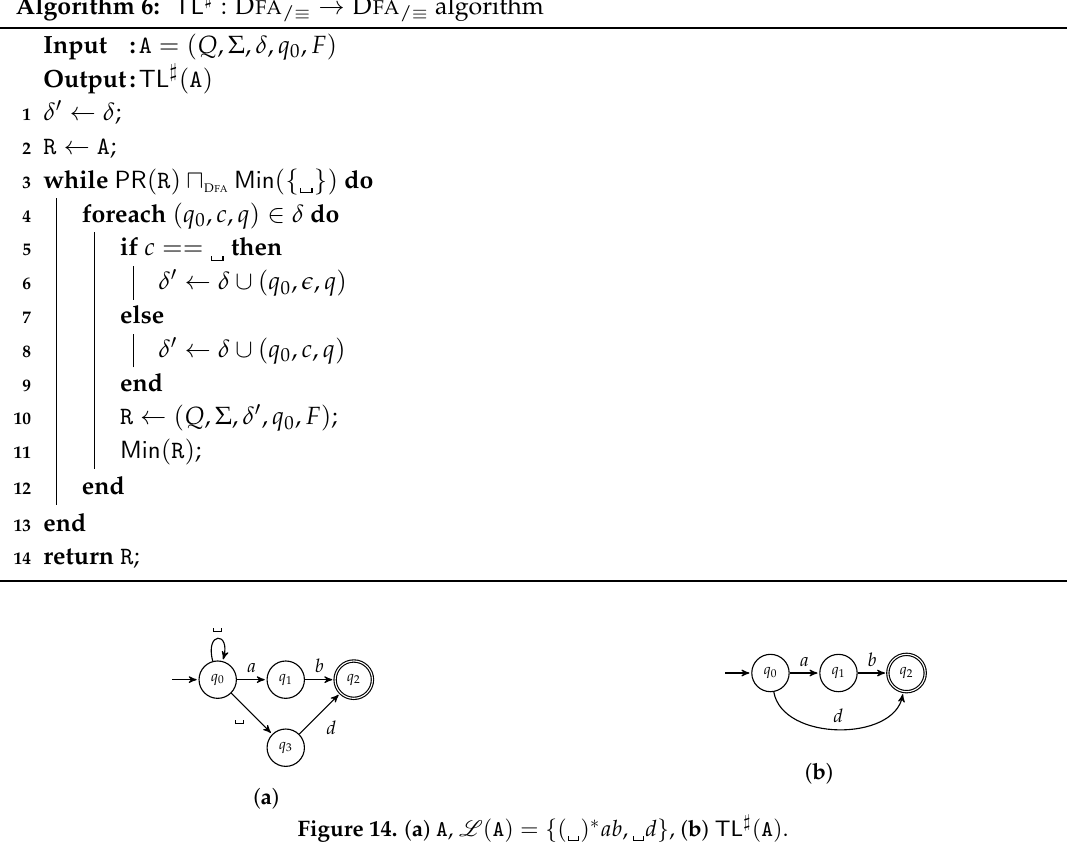
Algorithm 6: TL (cid:93) : D FA / ≡ → D FA / ≡ algorithm